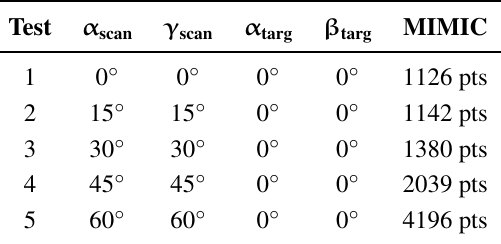
Table 3. The impact of dual axis scanner rotations on the number of pulses striking a parallel 2 m × 1 m target at a horizontal range of 5